Question: Write a single sentence explaining what this figure depicts.
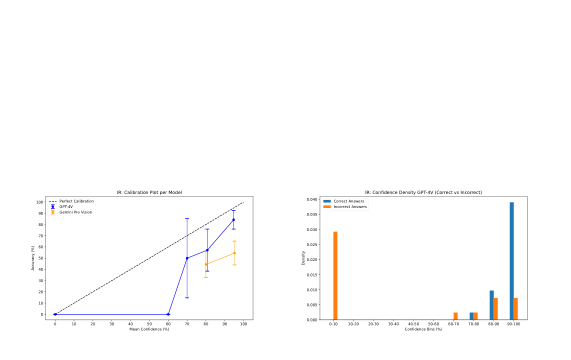
Answer: Calibration plot and confidence density his- togram for VLM image recognition on JUS. GPT-4V shows superior performance over Gemini Pro Vision.